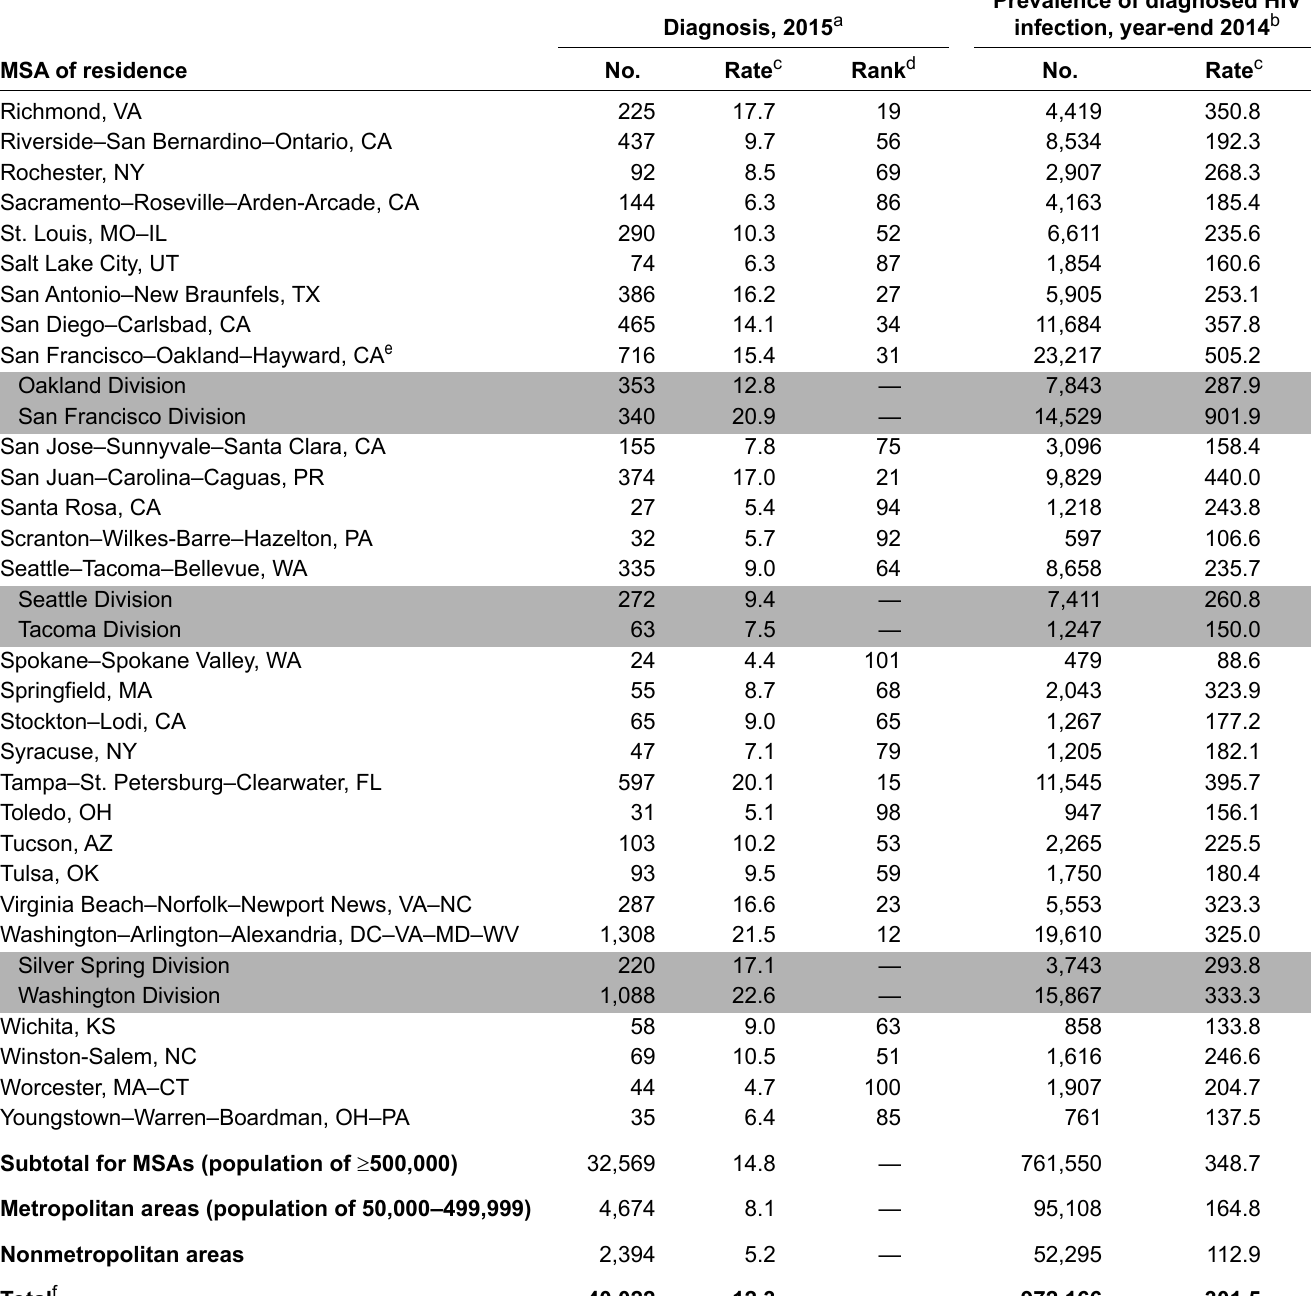
Table 26. Diagnoses of HIV infection, 2015, and persons living with diagnosed HIV infection (prevalence), year- end 2014, by metropolitan statistical area of residence—United States and Puerto Rico